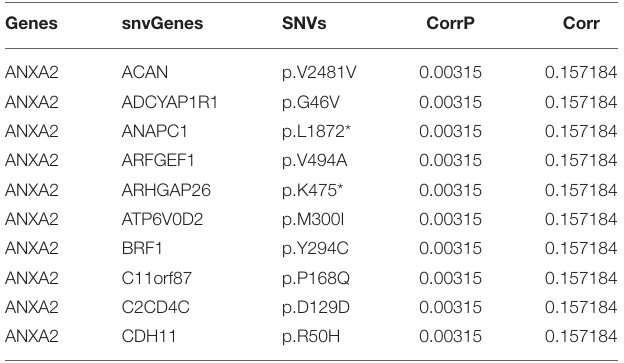
TABLE 3 | The top ten most significant associations between ANXA2 expression and SNVs.